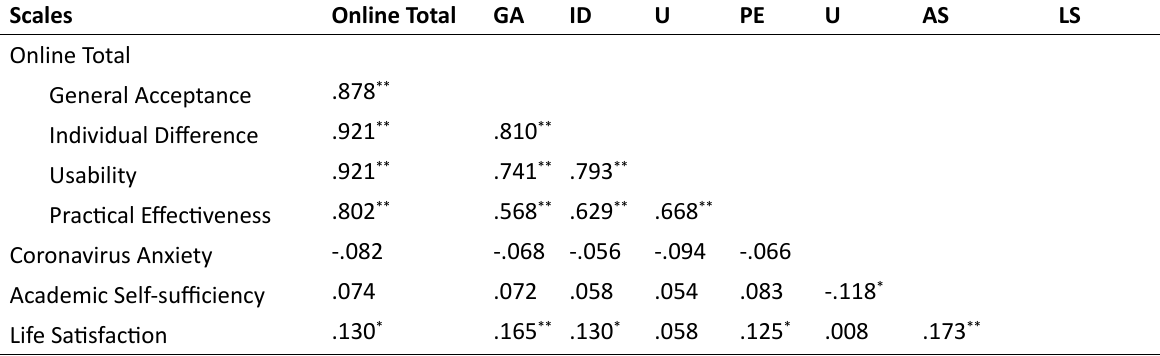
Table 2. Examination of the correlations between variables using pearson product-moment correlation analys i s.